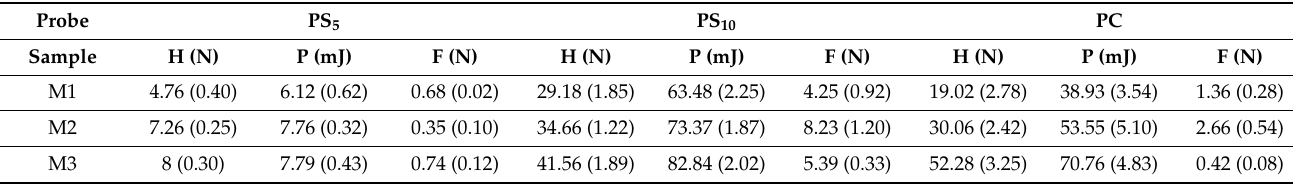
Table 4. The textural parameters of margarine